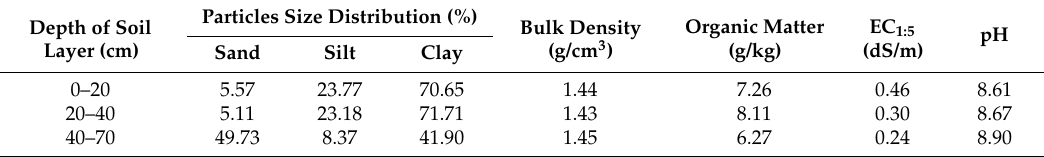
Table 1. Soil properties in the 0–70-cm soil layer of the experimental field.